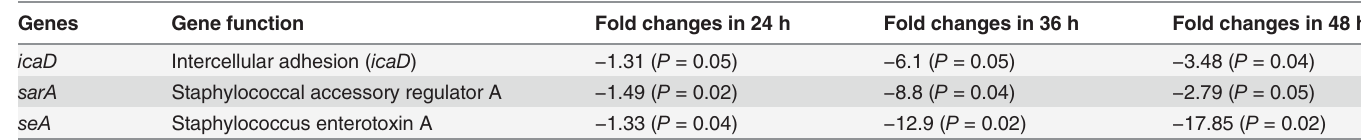
Table 3. Relative expression levels of icaD , sea and sarA in S. aureus (ATCC 29213) bio fi lms grown with eugenol at 0.5×MIC for 24, 36 and 48 h. Genes Gene function